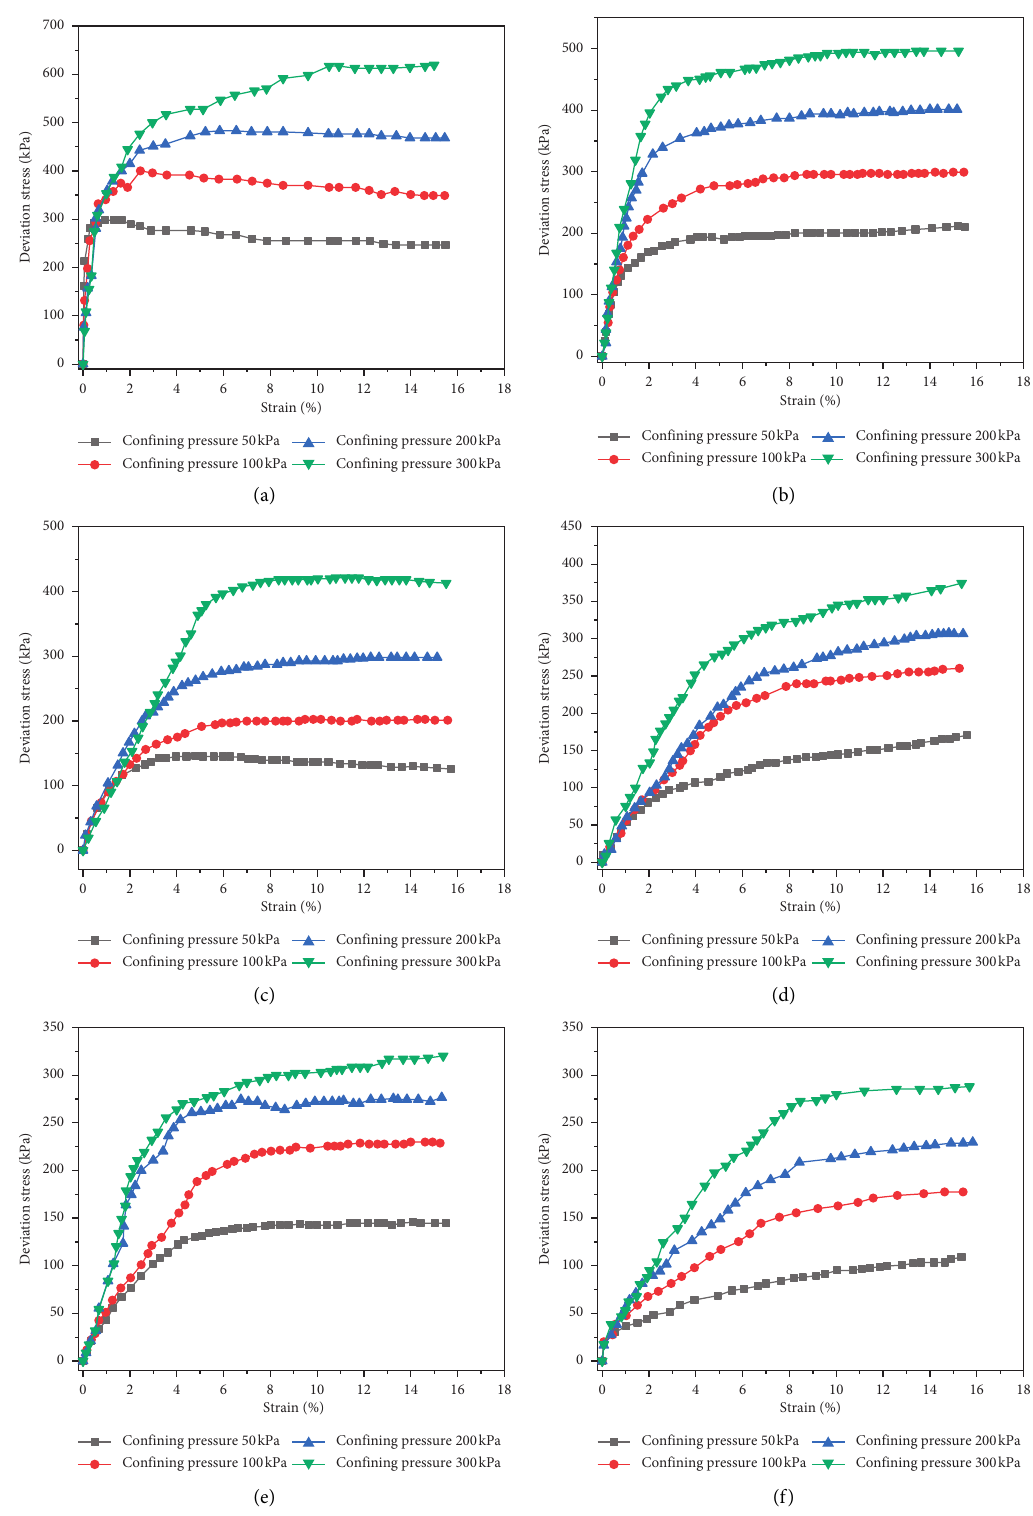
Figure 8: Stress-strain curves of the samples with an initial water content of w � 15% for different numbers of cycles. Moisture content w � 15% for (a) zero cycles, (b) one cycle, (c) two cycles, (d) three cycles, (e) four cycles, and (f) five